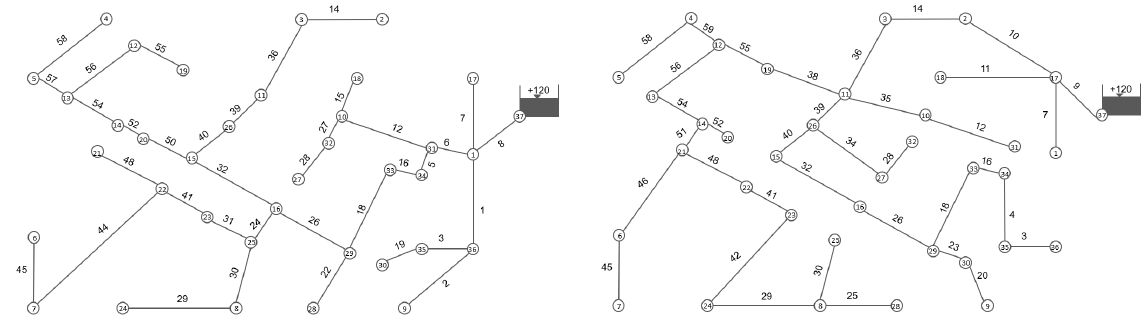
Figure 8. Schematic of pair of optimal backup pairs for Fossolo network.